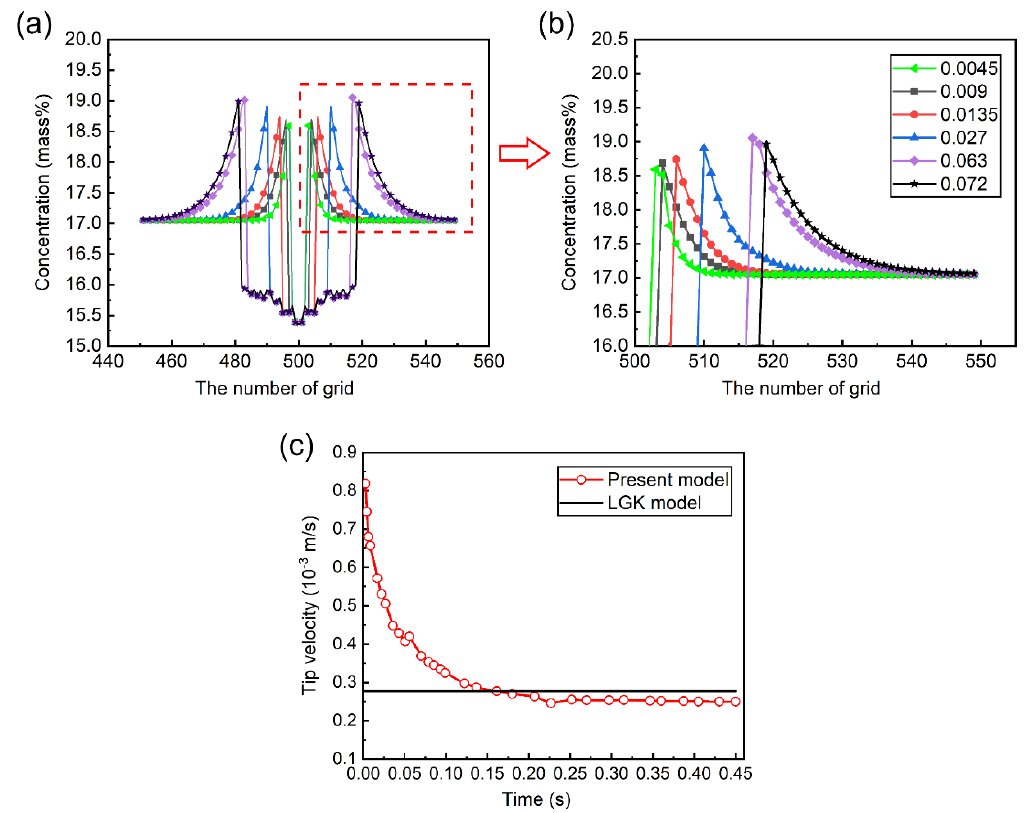
Figure 3. Characteristics of the solute distribution and the growth rate of dendrite tip obtained by simulation, at the conditions of ∆ T = 5 K and mesh size ∆ x = 0.5 µ m. ( a ) Solute distribution in the centerline of the dendrite arm at different times. ( b ) Partial enlargement of picture ( a ). ( c ) The calculated tip growth velocity as a function of time.